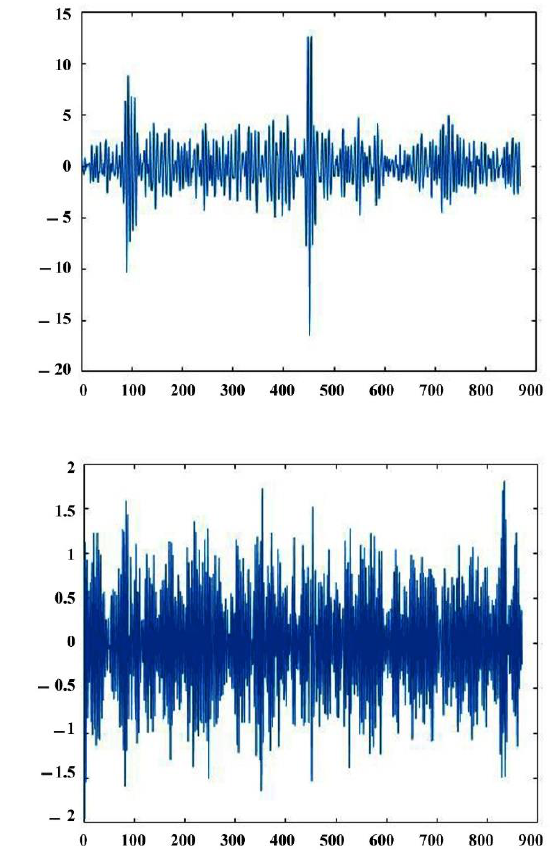
Figure 5. Five frequency sub-bands of an EEG signal using DT-CWT.